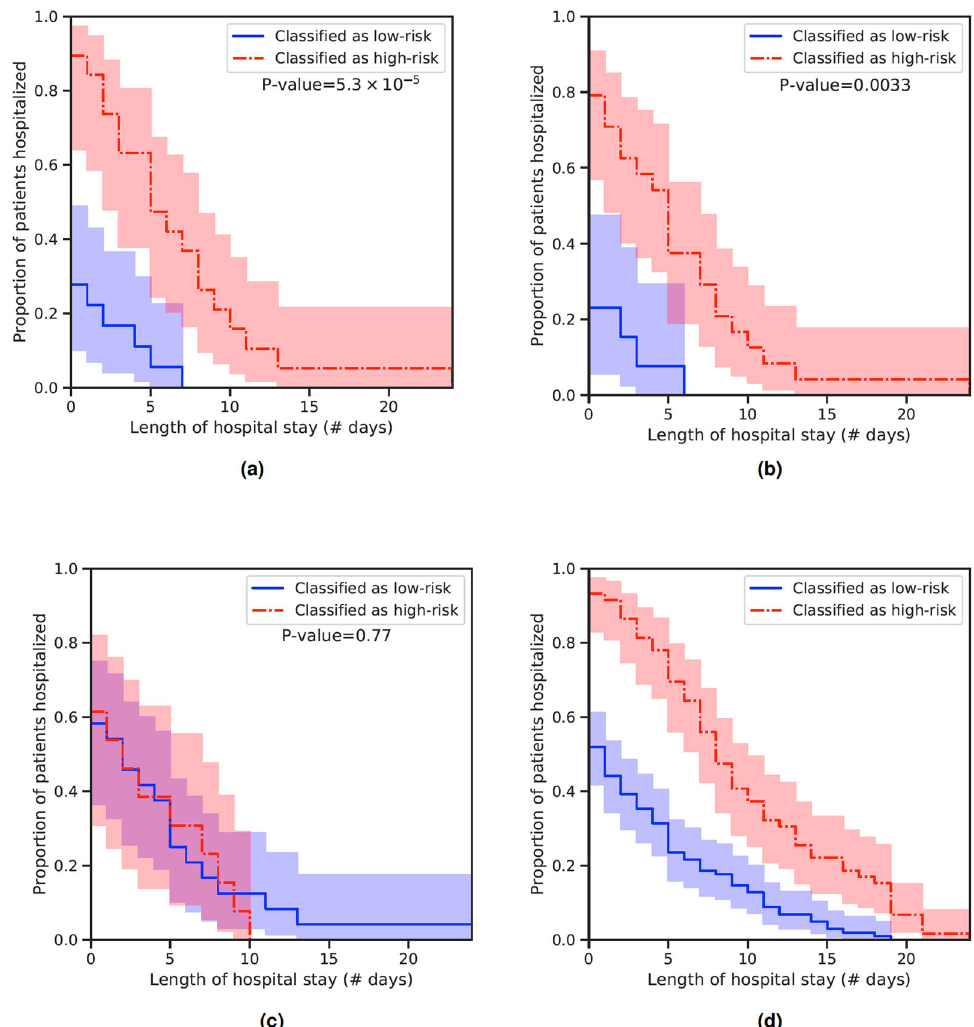
Fig. 11 Kaplan – Meier plots on COVID disease course. Different con fi gurations of DCD: ( a ) 1 prior + 1 follow-up scans, ( b ) 1 scan only, ( c ) age and sex only, ( d ) 1 prior + 1 follow-up scans (combines 5 validation folds in a 5-fold cross-validation